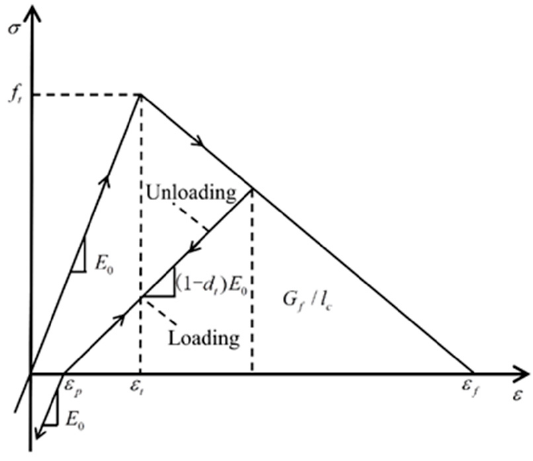
Figure 8. Stress-strain relationship of concrete under uniaxial cyclic loading. The calculation of f scr is shown in Equation (18).